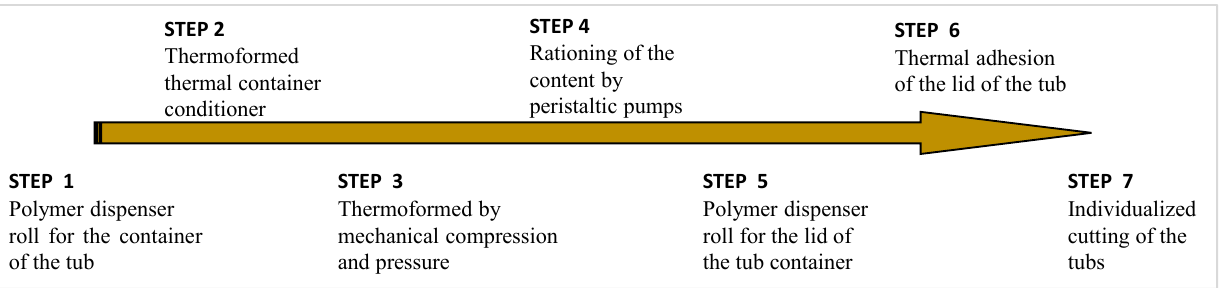
Figure 2. Subprocess in the studied MSTM.